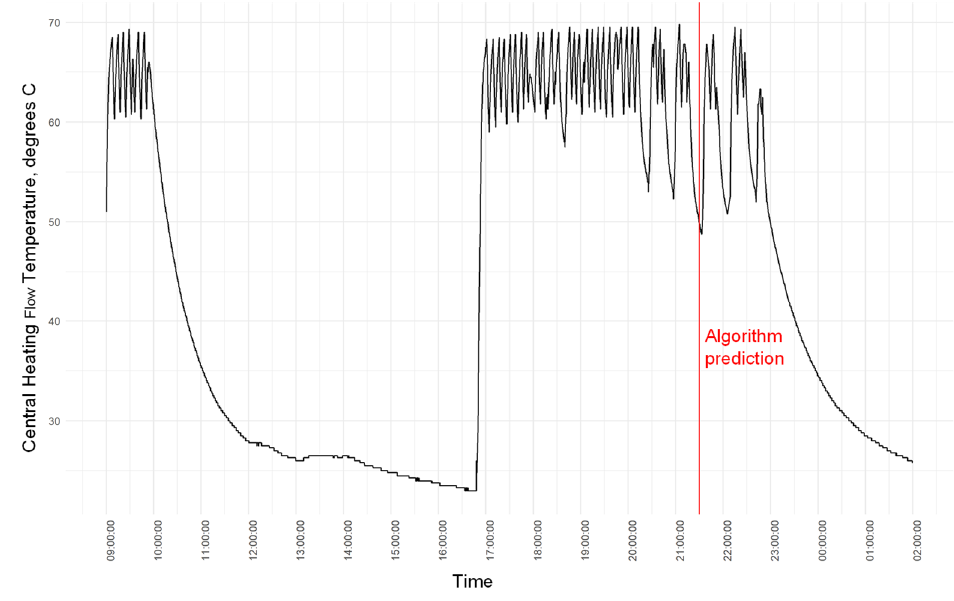
Figure A1. Comparison of the algorithm’s output to the ground truth for IDEAL home no. 135. Heating operation algorithm correctly predicts time of final heating switch off, to the nearest half hour.